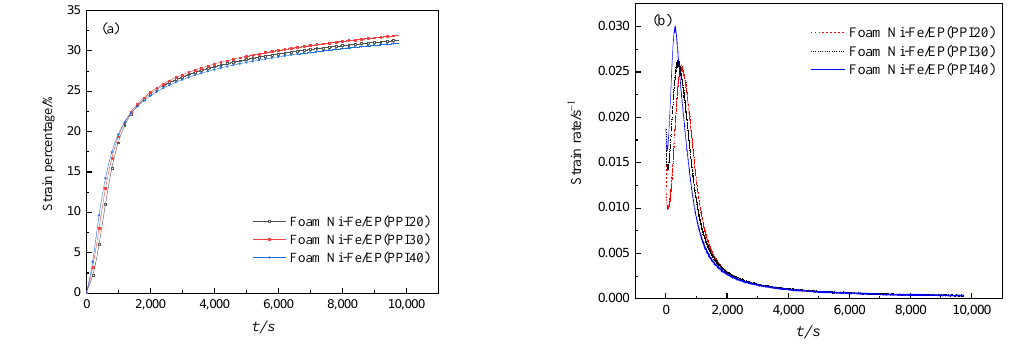
Figure 10. Curves of creep ( a ) and creep rate ( b ).